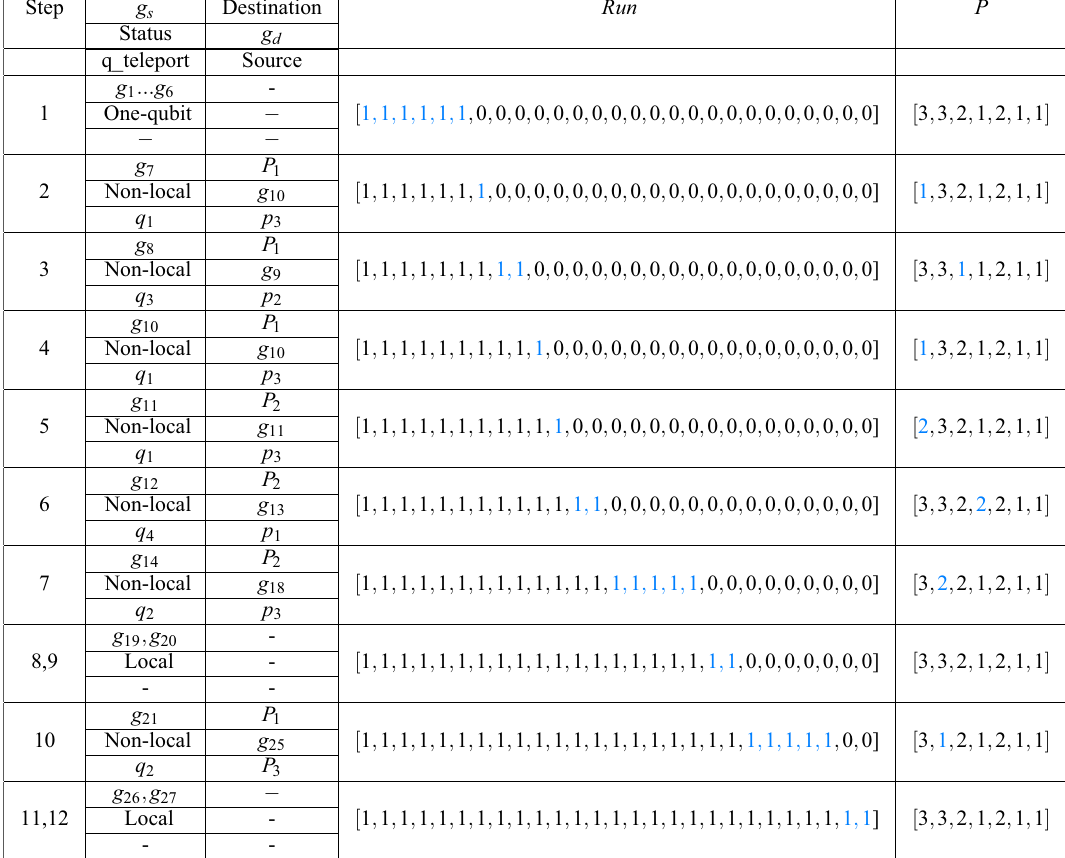
Table 2. The steps of distribution Circuit 2-4dec into 3 partitions with 7 qubits and 27